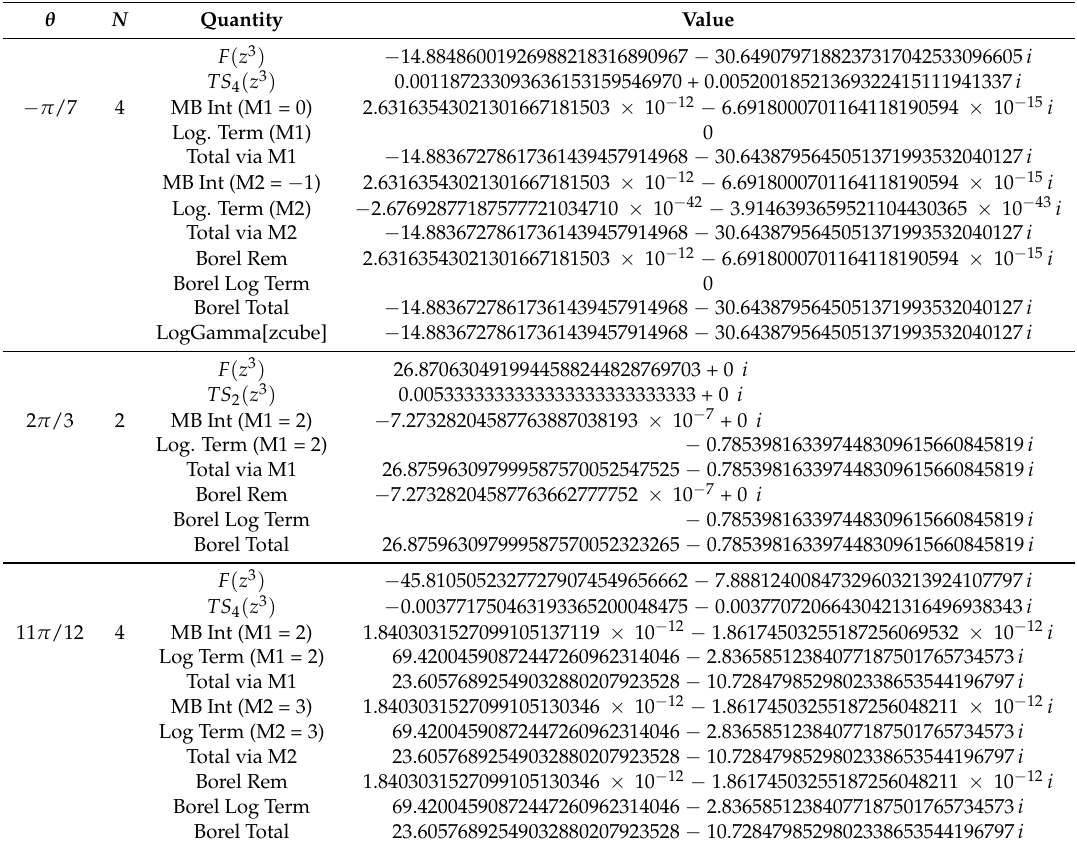
= 5/2 and various values of θ and N z | |